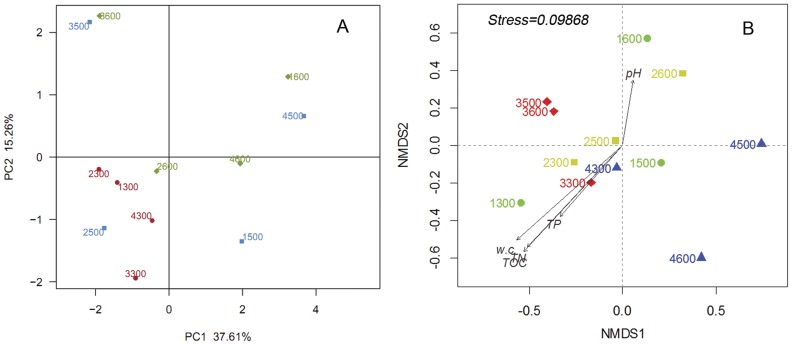
Sample sorting analysis.(A) Scatter plot of PCA-score showing similarity of the 12 bacterial communities based on Unifrac distance. Principal components (PCs) 1 and 2 explained 37.61% and 15.26% of the variance, respectively. (B) NMDs showing the difference of bacterial communities according to Bray-Curtis distance. TOC: total organic carbon, TN: total nitrogen, TP: total phosphorous, and w.c.: absolute water content (per gram dry soil).